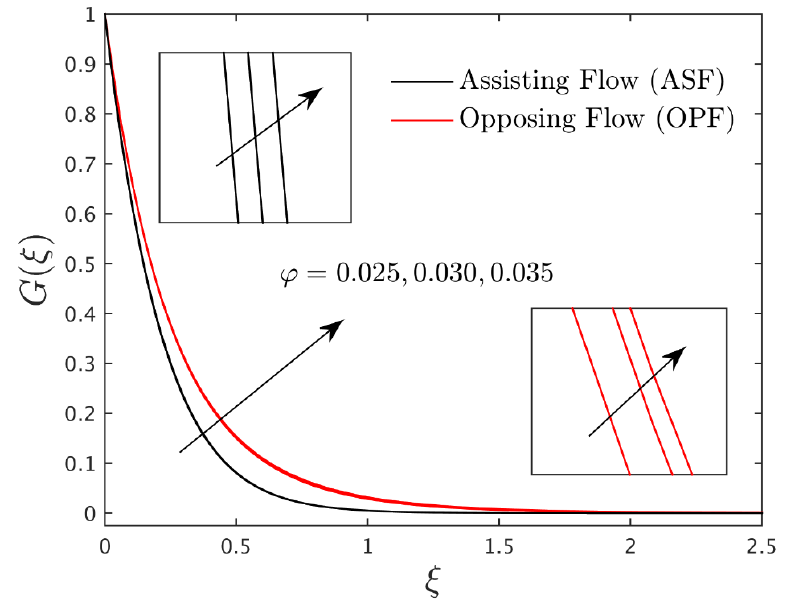
Figure 6. Temperature profile for the case of ASF and OPF due to variations in the values of ϕ .